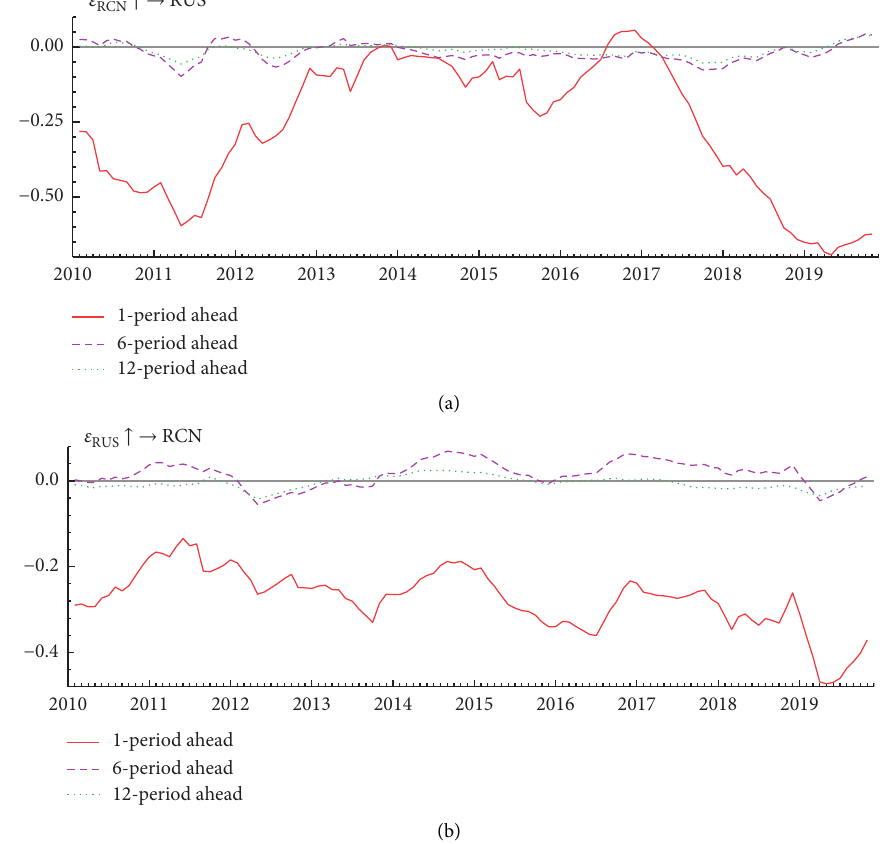
Figure 9: Time-varying impulse responses of China and the US stock market